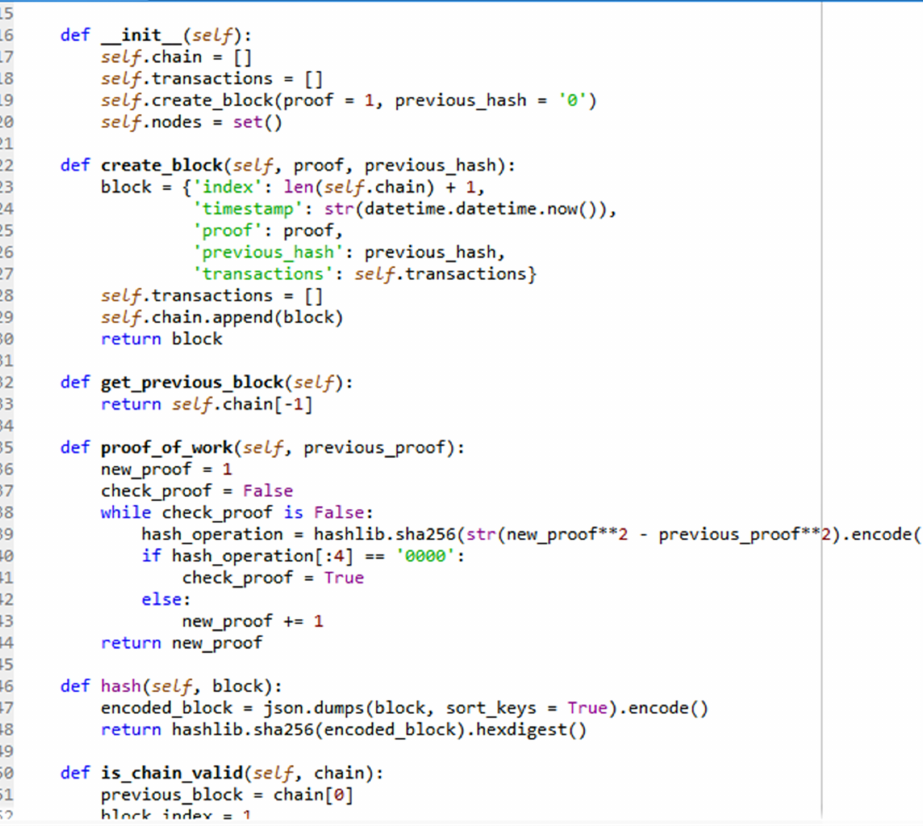
Figure A3. Construction of Block and PoW.